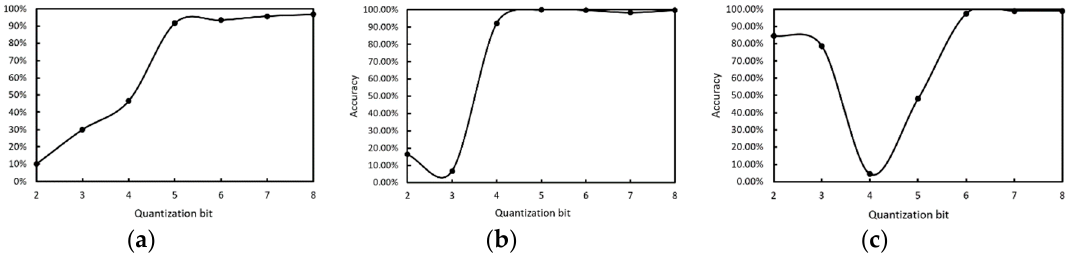
Figure 13. The accuracy of different quantization bits in the WBC classification network. ( a ) Figure13. Theaccuracyofdi ff erentquantizationbitsintheWBCclassificationnetwork. ( a )lymphocytes, lymphocytes, ( b ) monocytes, ( c ) neutrophilic. ( b ) monocytes, ( c ) neutrophilic.